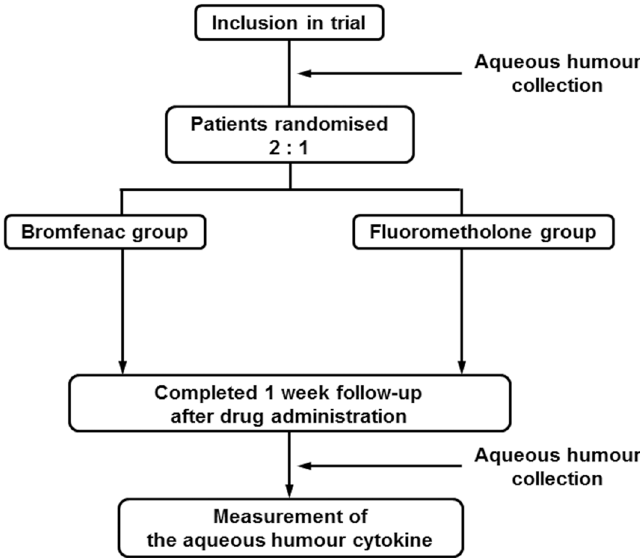
Figure 1. Study design. Patients with pseudophakic eyes who met the inclusion criteria were randomised 2:1 to receive either bromfenac or fluorometholone eye drops. All investigators and statisticians were blinded to